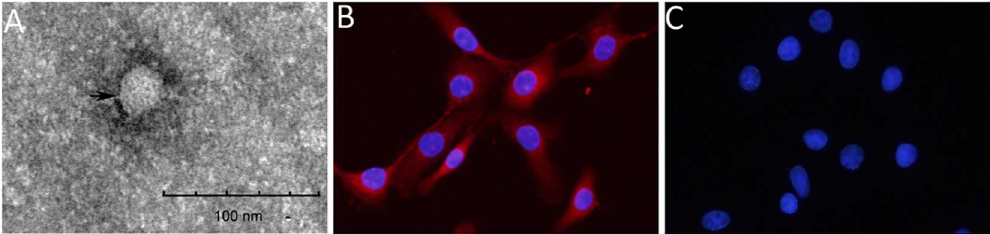
Fig 1. SD-15 is a noncytopathic BVDV isolate responsible for the outbreak. Viral particle was observedby electron microscopy (A). BVDV antigen was detected in MDBK cells infected by the inoculumby indirect immunofluorescenceassay (B). Normal MDBK cells was detected by IFA (C). The scale bar was indicatedas 100 nm.